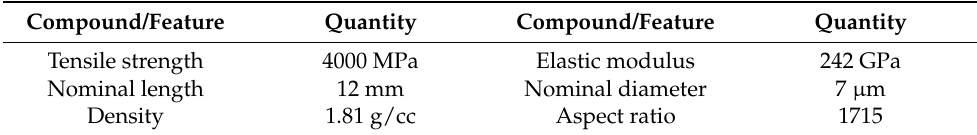
Table 3. Physical and chemical characteristics of carbon Table 2. Properties of NS.